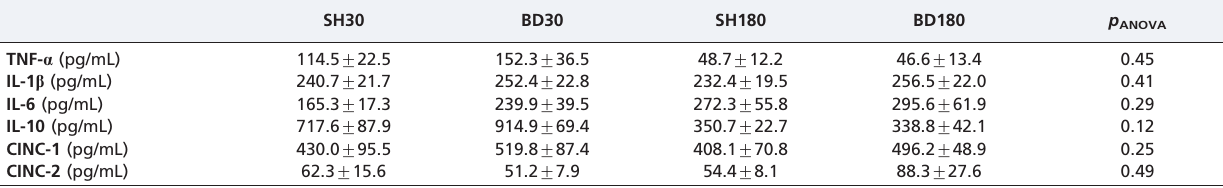
Table 2 - Enzyme-linked immunosorbent assay of serum cytokines and chemokines. SH30 BD30 SH180 BD180 p ANOVA TNF- a